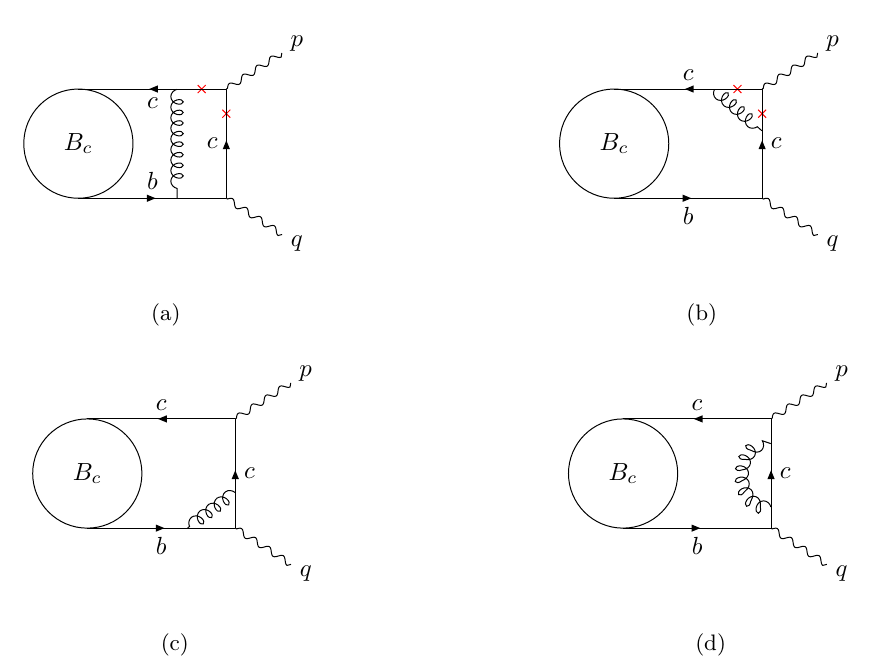
Figure 2 . The NLO, O ( α s ) diagrams: (a) the box, (b), (c)- the vertices and (d)-the self-energy of c -quark. Crosses indicate the cuts relevant for the sum